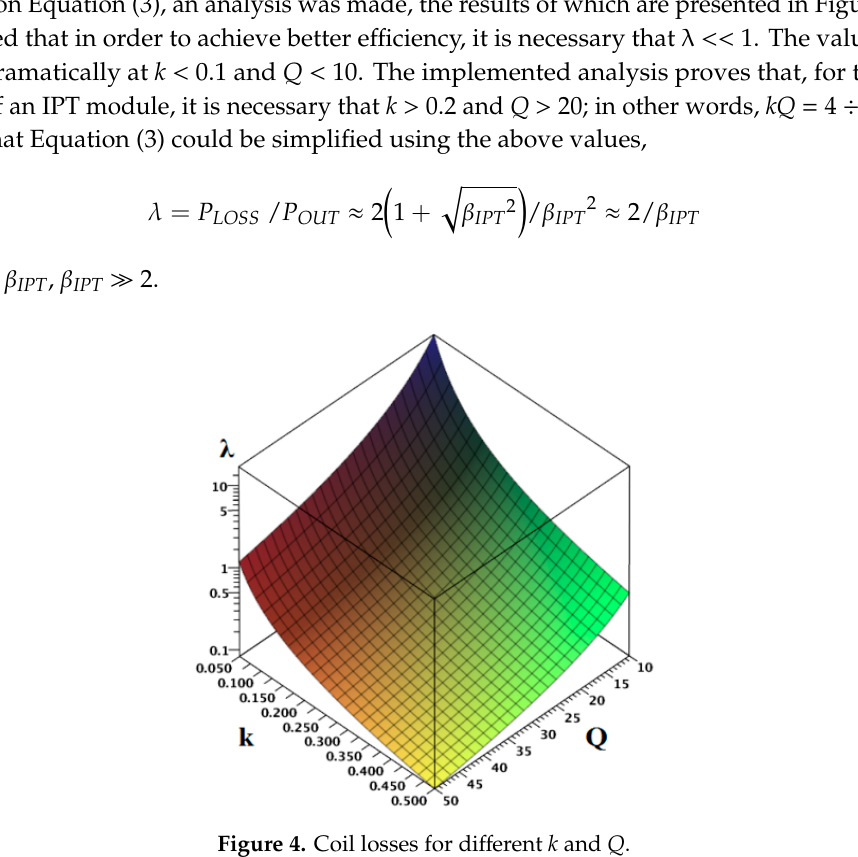
Figure 4. Coil losses for different k and Q .